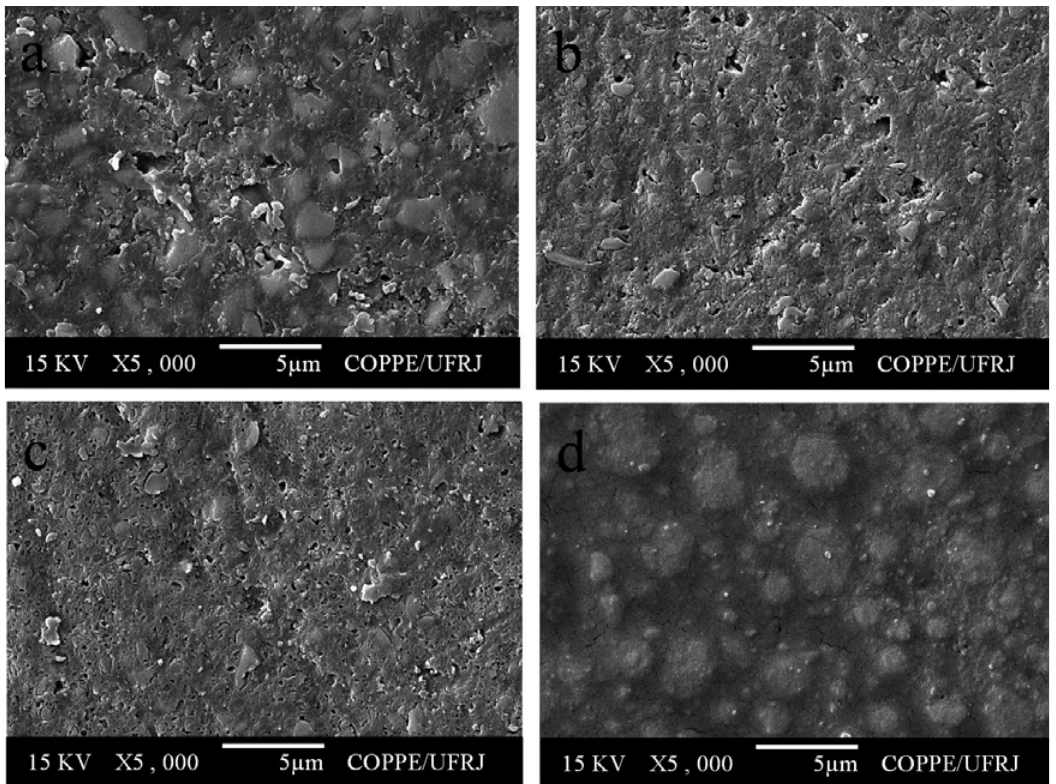
FIGURE 3- Representative SEM micrographs of resin-based composites before pH-cycling. (a) TPH, (b) Concept, (c) Opallis and (d) Supreme